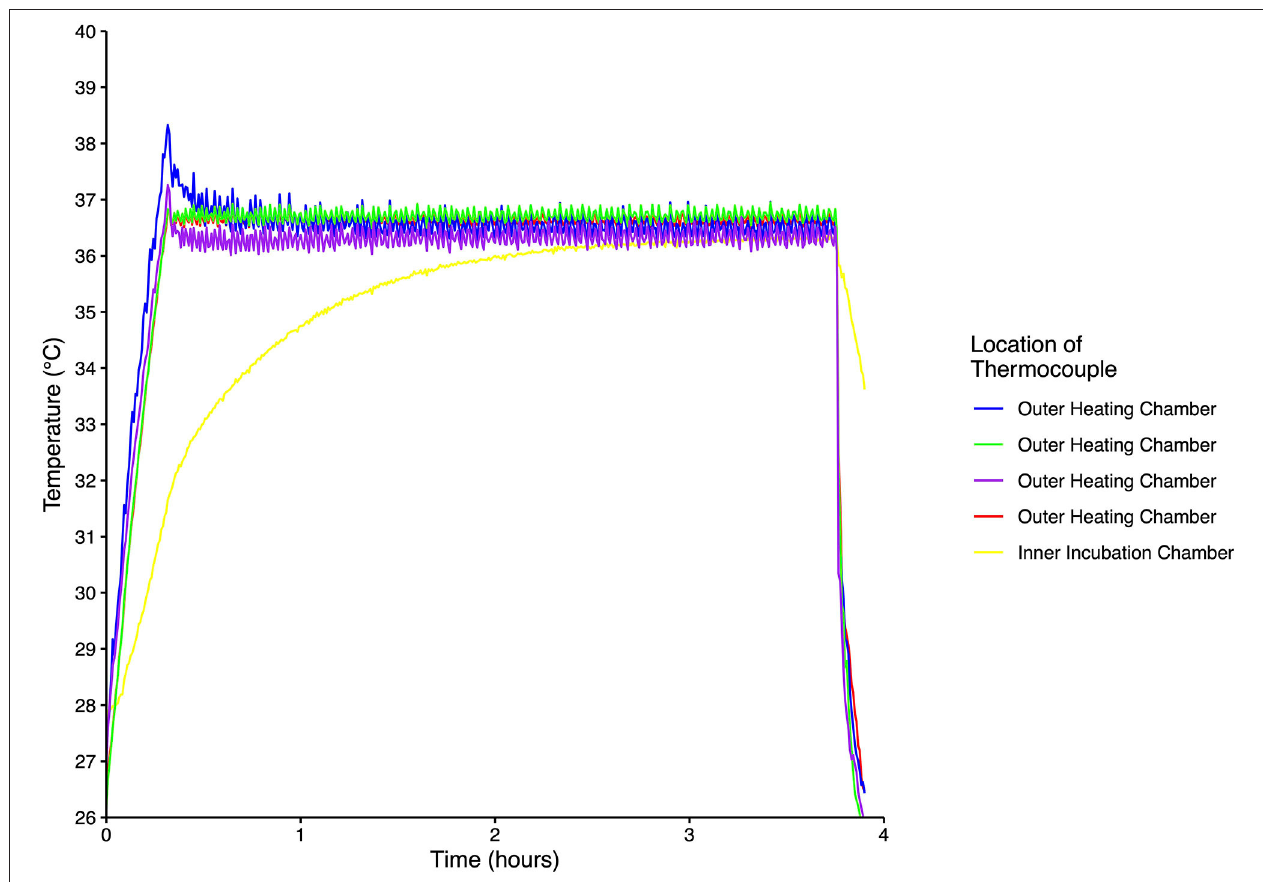
FIGURE 2 | Temperature recordings from five thermocouples placed inside one incubator. Measurements were taken every 30s for ∼ 4h at an ambient temperature of 26 ◦ C.